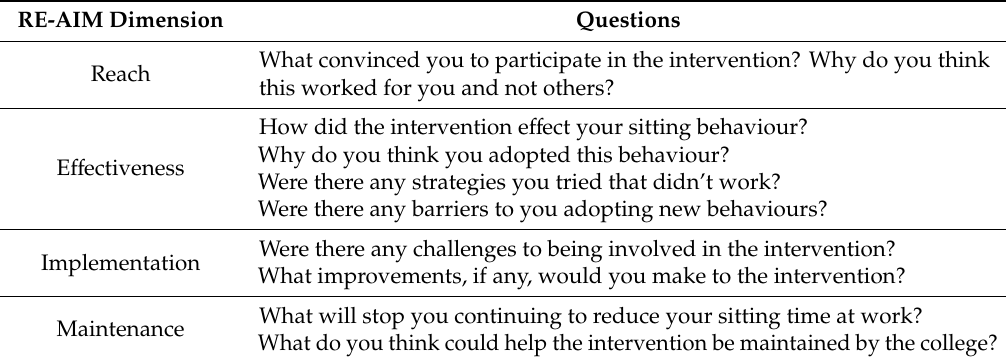
Table 1. Example questions from focus group and interview topic